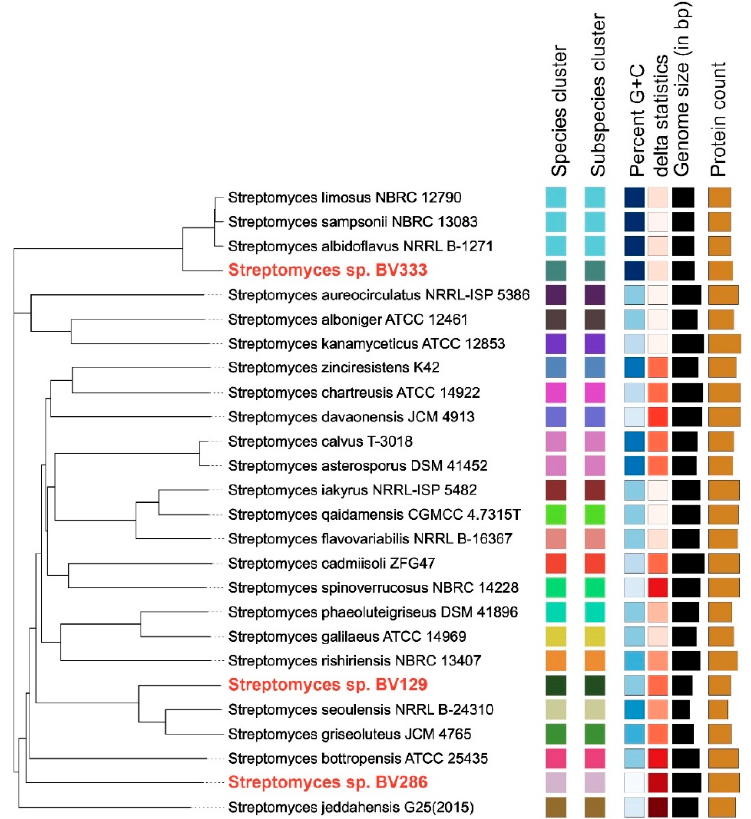
Figure 2. Phylogenetic tree inferred with the FastME 2.1.6.1. using whole-genome comparison with Streptomyces sp. BV129, BV333 and BV286 highlighted in red.